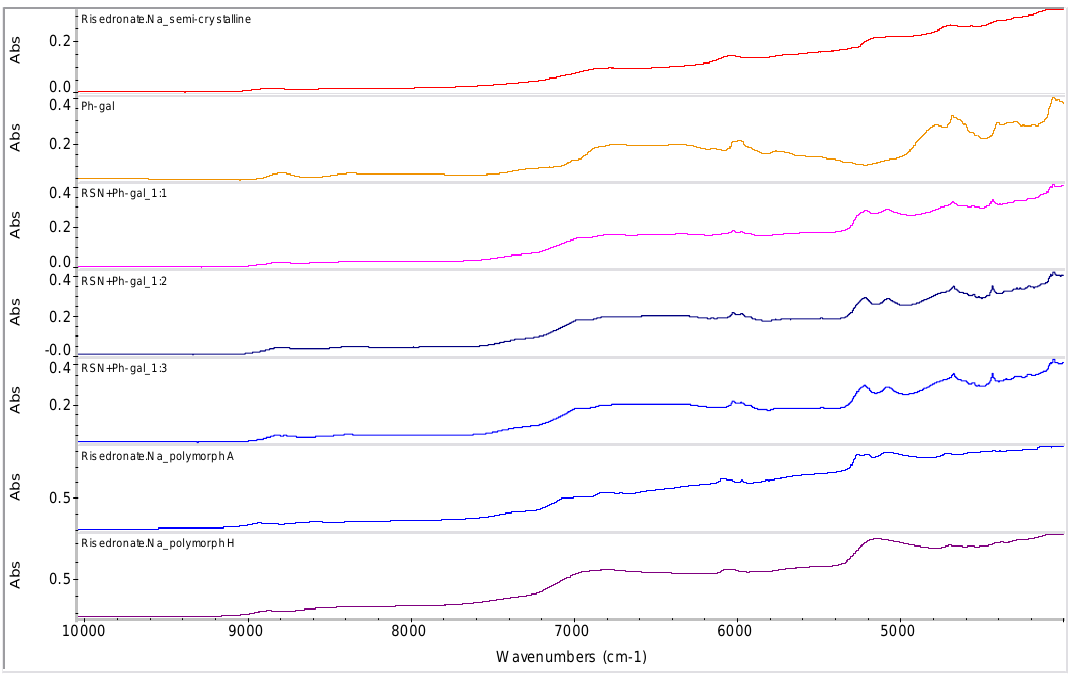
Figure 10. NIR spectra of semi-crystalline risedronate monosodium salt (RSN), forms A and H and phenyl- β - D -galactopyranoside (Ph-gal) and spectra of their mixtures in ratios 1:1, 1:2 and 1:3 prepared by evaporation at ambient temperature (samples 1 - 3 ).